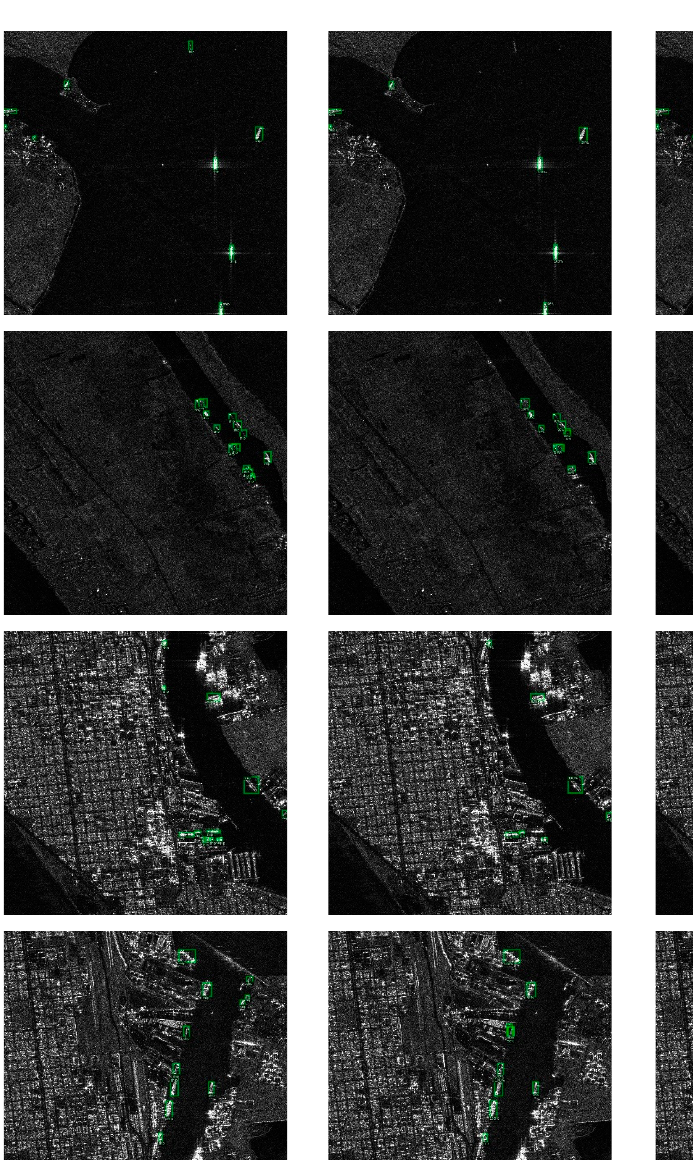
Figure 9. Visualization results of ablation experiments on the SAR-Ship-Dataset. ( a ) Ground truths. ( b ) Detection results of FCOS trained by focal loss. ( c ) Detection results of FCOS trained by GAP loss. ( d ) Detection results of FCOS with SCSA module trained by GAP loss.